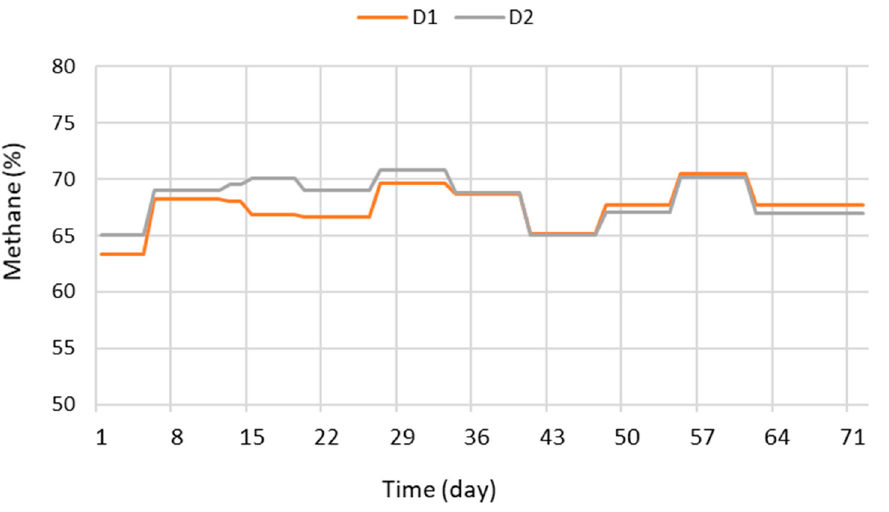
Figure 4. Evolution of methane concentration in biogas.